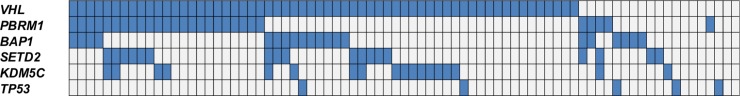
Somatic variants in 79 clear cell mRCC tumors.